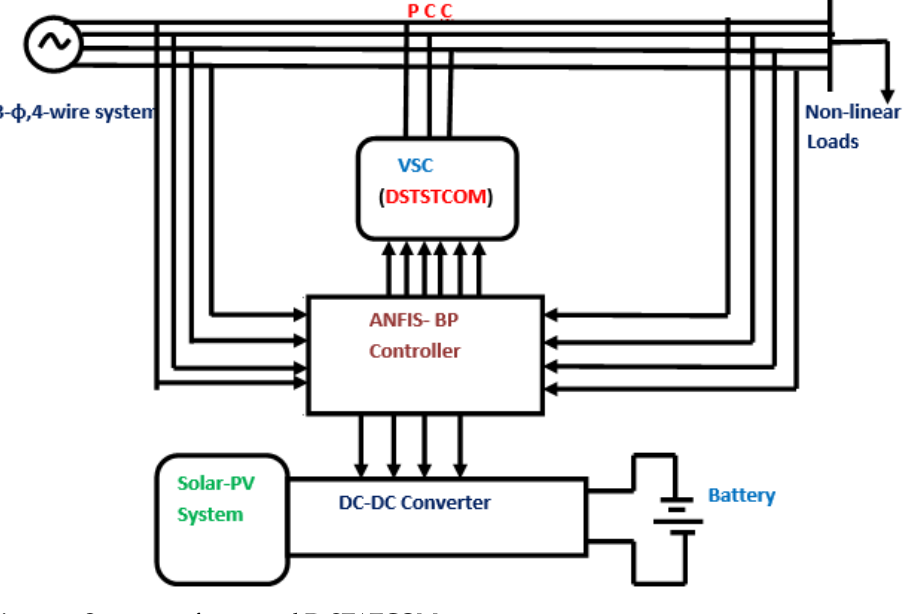
Figure 2. Structure of proposed D-STATCOM.